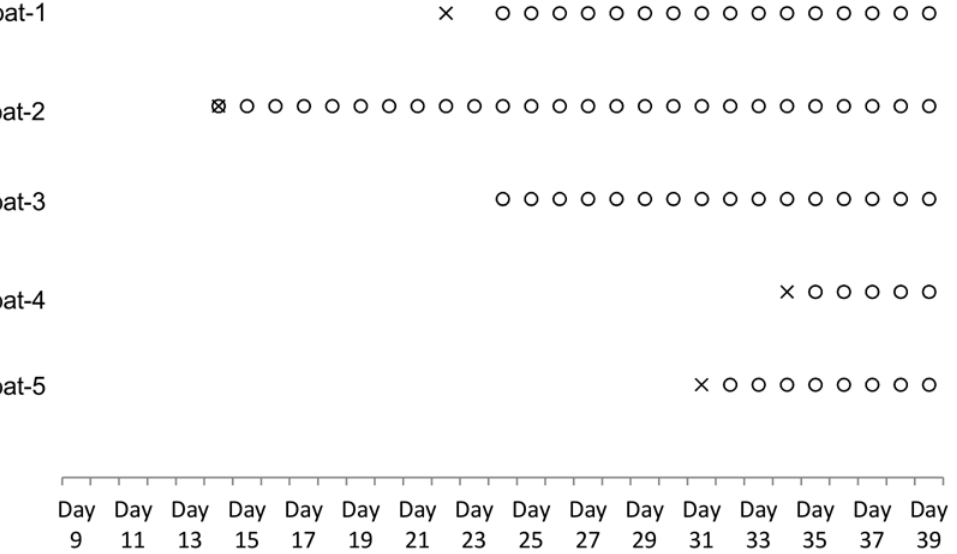
Fig 3. Time course of SFTSV-specific RNA and antibody response in goats in natural infection study. 5 na ï ve goats were farmed in SFTSV endemic site from Day 0 (19 April, 2012), and daily serum samples were taken from each goat to monitor viral infection. 4 of 5 goats in the cohort were viremic over a very short period (less than 24hr) after infection (from Day 14 to Day 34), soon occupied by a timely mounting antibody response simultaneously or 1 – 2 days later, which effectively controlled the infection. × viral RNA detected in goats sera; (cid:1) viral total antibodies detected in goats sera.